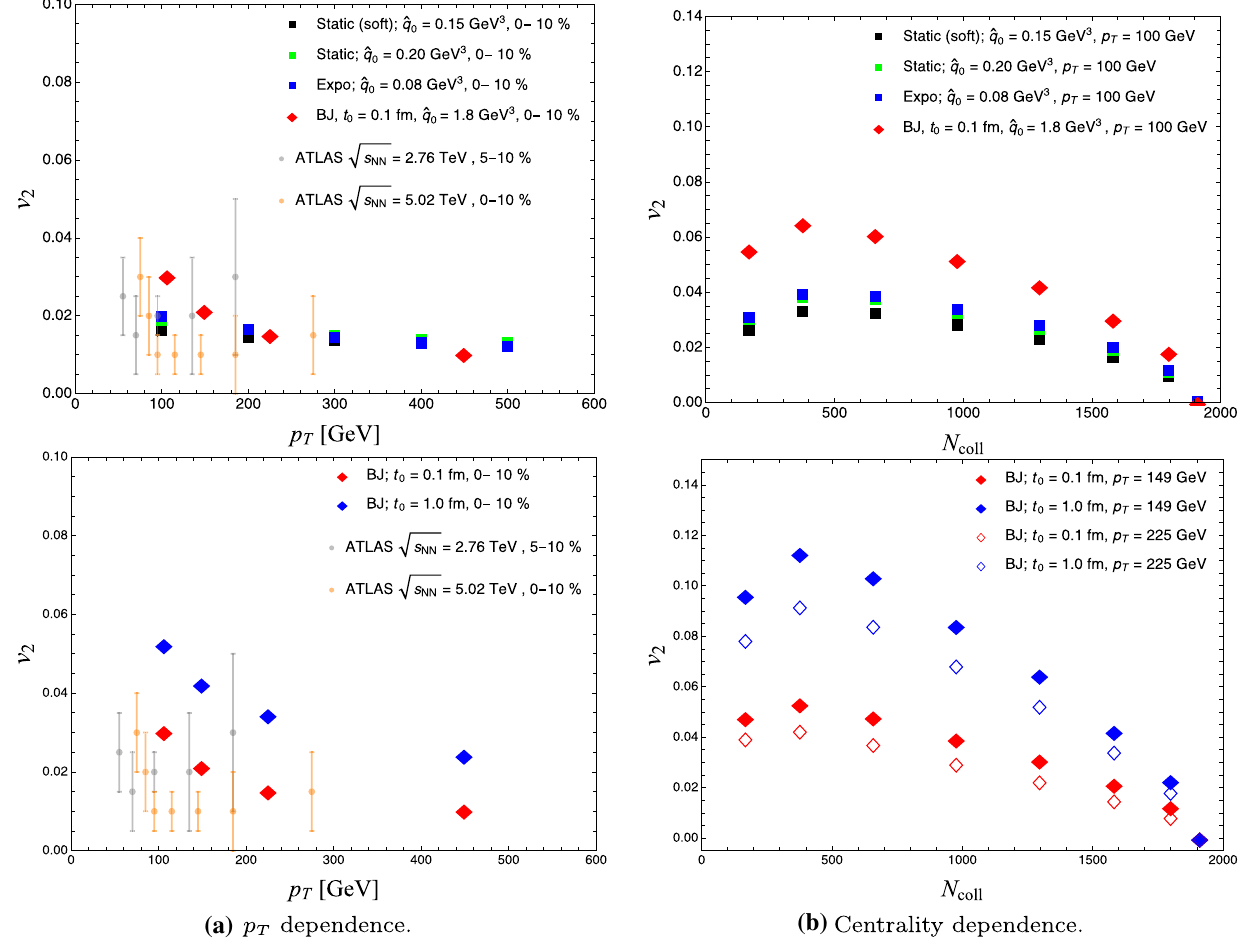
Fig. 5 The jet v 2 elliptic flow for the static and expanding profiles with optimized ˆ q 0 as a function of impact parameter p T (left) and N coll right. Upper panels show the jet v 2 for static medium, exponential medium,